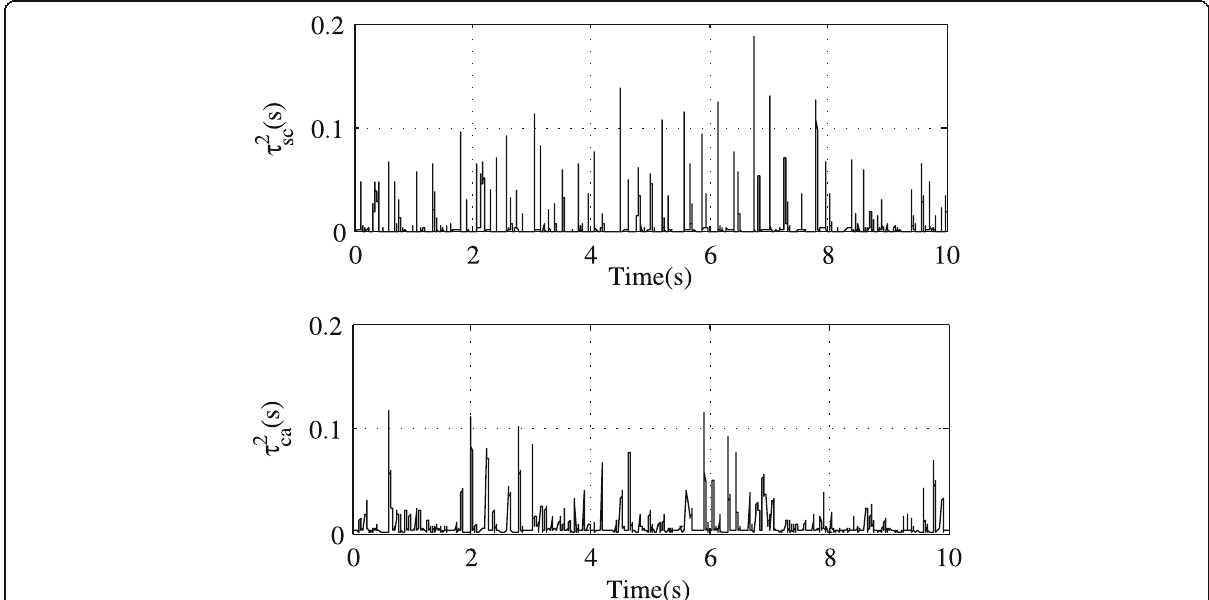
Fig. 8 The SC and CA delay distributions of loop 2 when the model matches the generalized